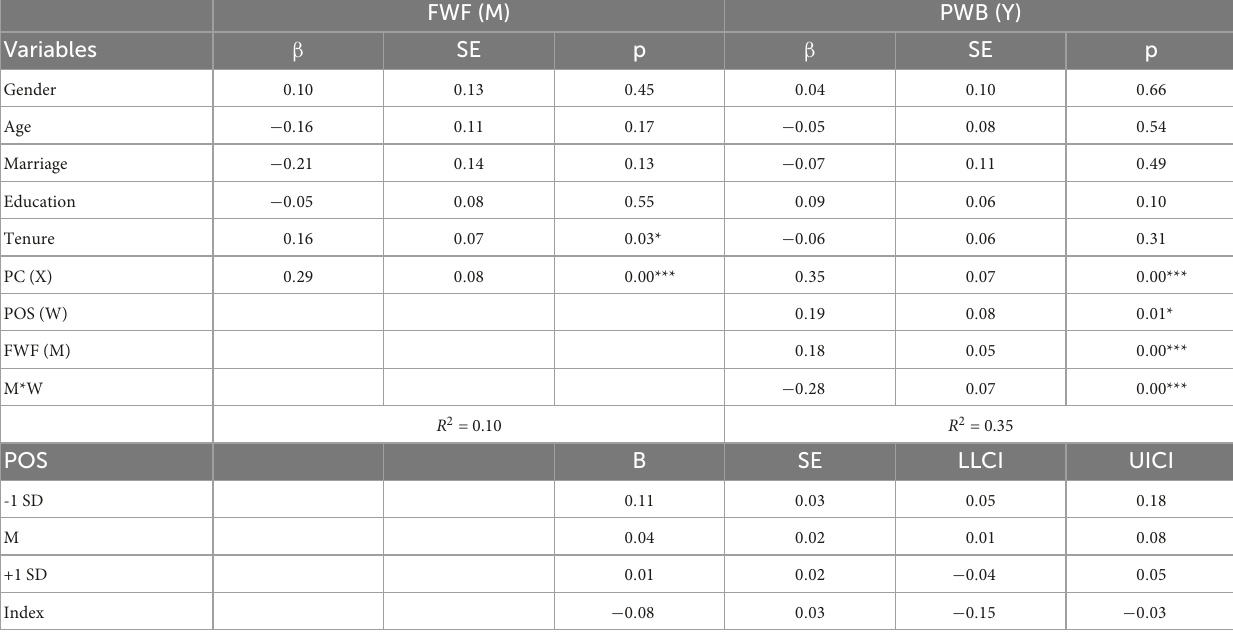
TABLE 8 Results of moderated-mediation of